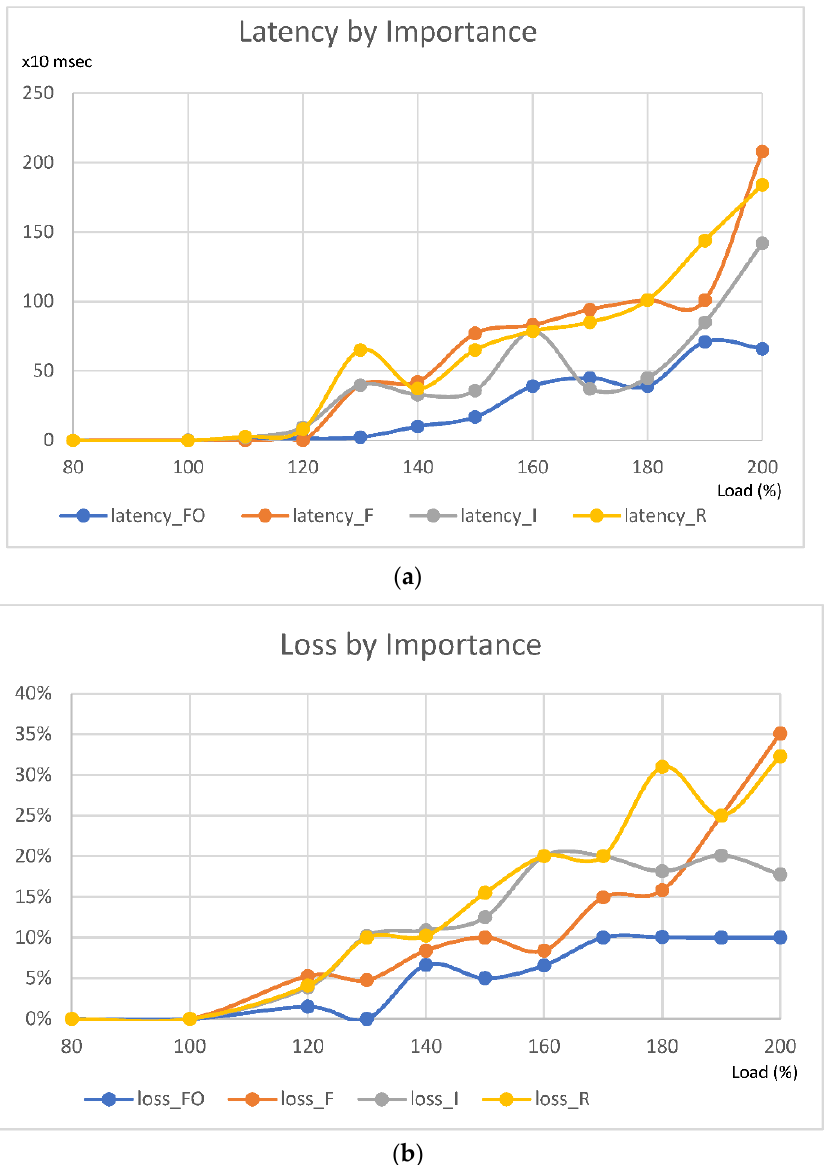
Figure 8. Performance results by importance for the EF, AF4, AF2 and DF traffic: ( a ) Latency performance by importance level; ( b ) Loss performance by importance level.